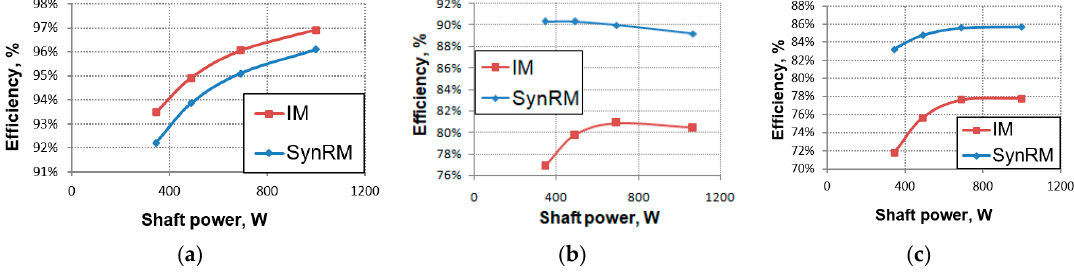
Figure 15. Calculated efficiency: ( a ) CDMs; ( b ) Motors; ( c ) Drives.